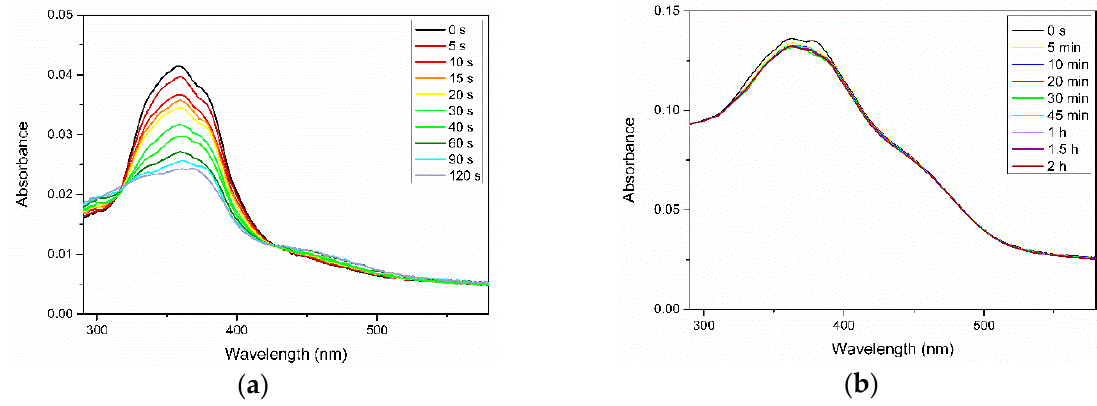
Figure 4. Variations in the UV–Vis spectra of ( a ) neat Azo and ( b ) 50:50 Azo / PEG complex in thin films during UV irradiation. The complex compositions are designated in wt %.